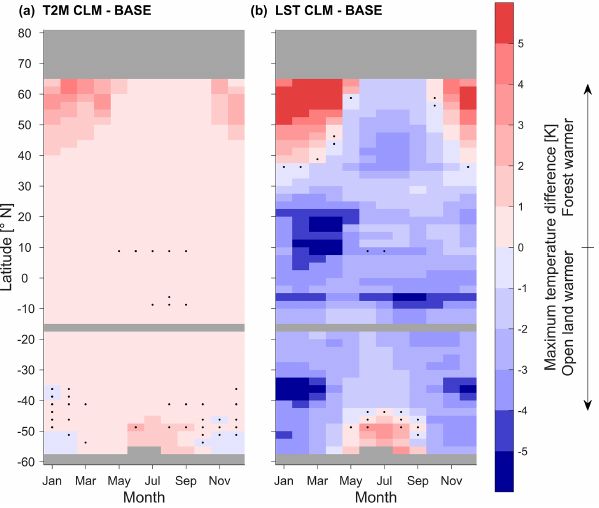
Figure 9. Seasonal and latitudinal variations of (a) daily maximum T2M difference of forest minus open land and (b) (cid:49) LST max (f − o) in CLM-BASE. Points with a mean which is insignificantly dif- ferent from zero in a two-sided t test at 95% confidence level are marked with a black dot. All data from the 2002–2010 analysis pe- riod corresponding to a given latitude and a given month are pooled to derive the sample set for the test. Only grid cells containing valid data in the MODIS observations were considered for the